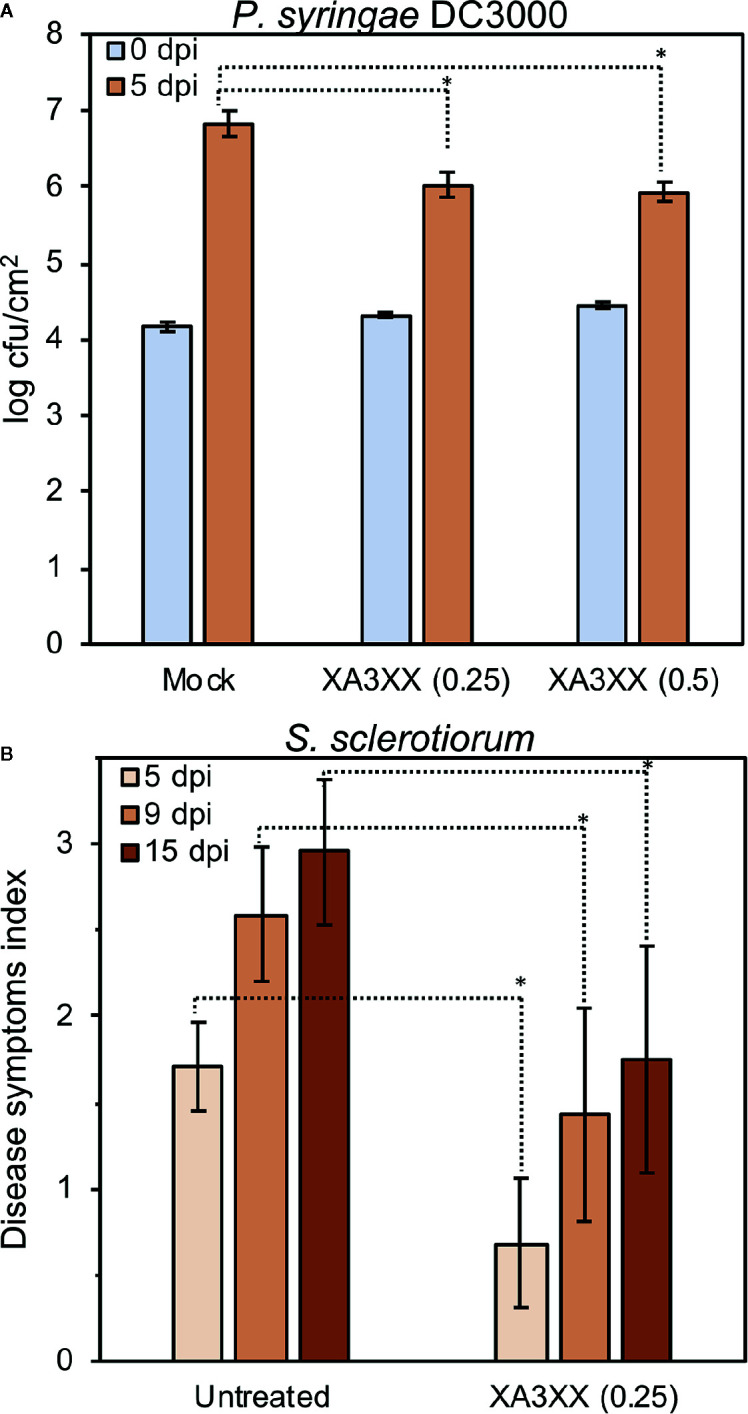
Treatment of tomato and pepper plants with arabinofuranosyl-xylotetraose (XA3XX) confers enhanced disease resistance to pathogens. Plants were foliar-treated with XA3XX (0.25–0.5 mg/plant) 2 d prior bacterial or fungal inoculation. (A) Colony forming units (cfu) of Pseudomonas syringae pv. tomato DC3000 per leaf area (cm2) at 0- and 5-d post-inoculation (dpi) in three-week-old tomato plants. Cfu/cm2 were determined after plating serial bacterial dilutions obtained from tomato leaf discs of known area onto KB plates. Data represent mean ± SD (n=8). (B) Disease symptoms index produced by Sclerotinia sclerotiorum at 5-, 9-, and 15-dpi in leaves of pepper plants. Data represent mean ± SD (n=24). Statistically significant differences according to Student’s t-test (*p < 0.05).